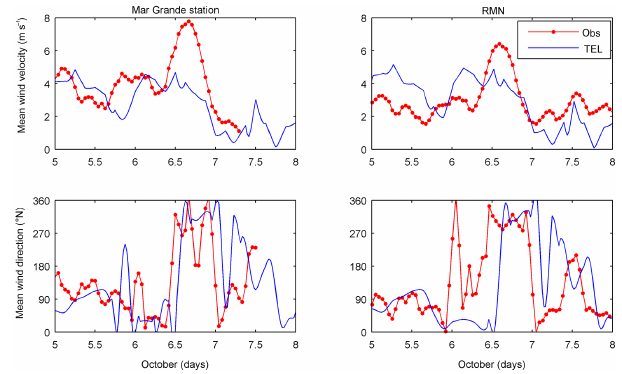
Figure 4. Wind characteristics at Mar Grande (left panels) and RMN (right panels) stations: velocity magnitude (top panels) and direction (bottom panels) from the interpolated COSMO-ME val- ues on the TELEMAC grid (blue line) and from observations (red line and circle markers).